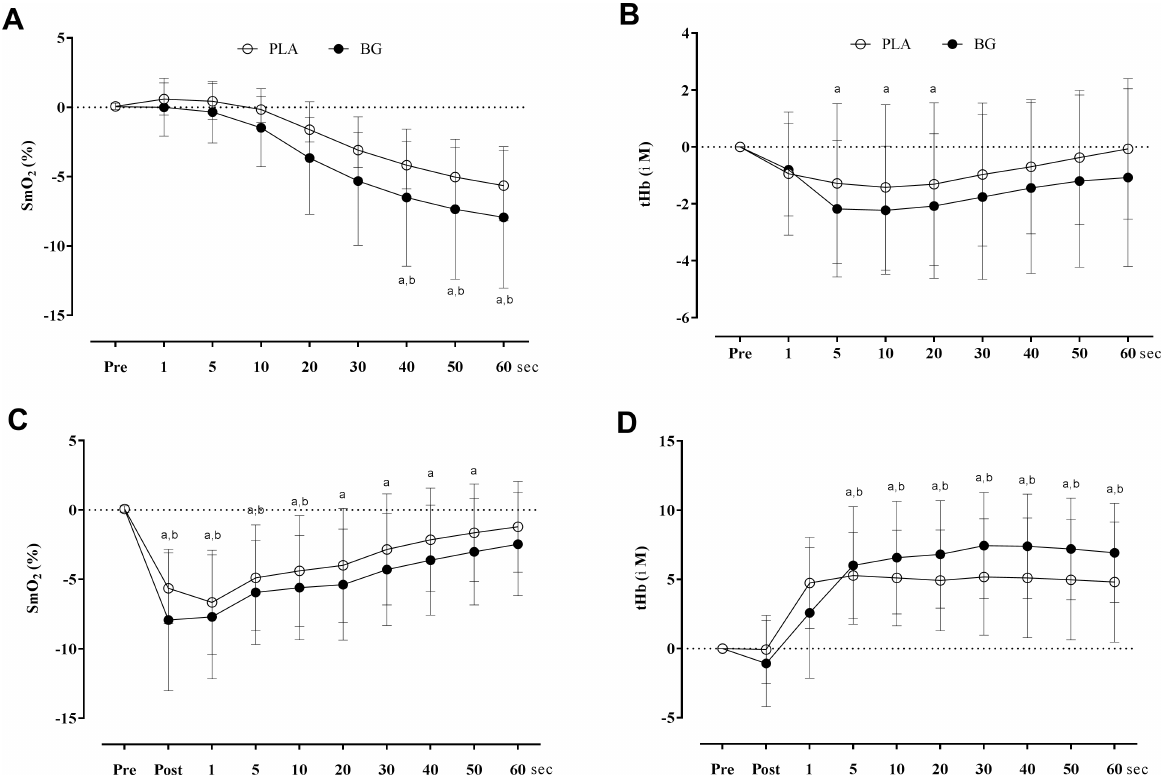
Fig 3. Values of muscle oxygenation ( Δ SmO 2 , %) and blood volume ( Δ tHb, μ M) during( A and B, respectively)and following( C and D , respectively)the rhythmic handgripexercise after beetroot-based nutritionalgel (BG) and nitrate-depleted gel (PLA) intervention. Pre = baseline; Post = post-exercise. a significantly different from Pre for BG and b significantly different from Pre for PLA.